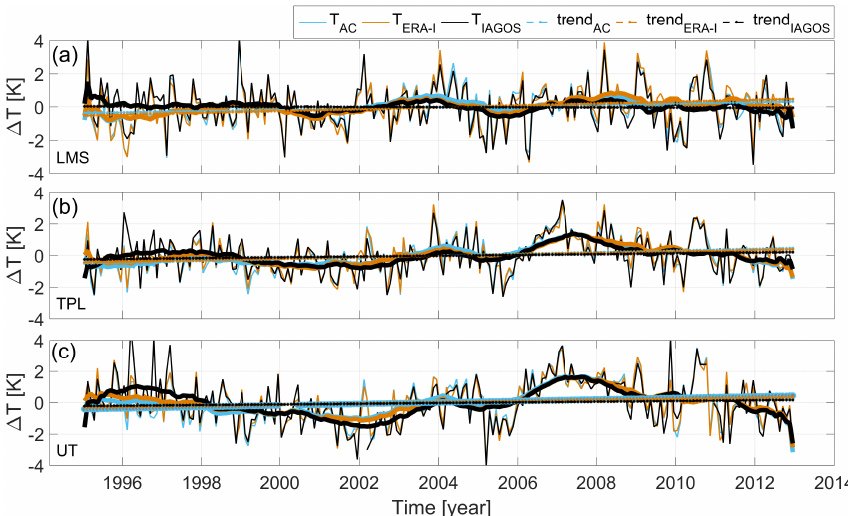
Figure 7. Anomalies in monthly averaged temperature in the (a) LMS, (b) TPL, and (c) UT over the North Atlantic region from IAGOS observations (black), ERA-I (orange), and aircraft measurements (AC, light blue). The aircraft measurements are assumed to be comparable to AMDAR data. The anomalies are smoothed with a 12-month running mean to highlight the behavior of the time series, which reflects the temperature trends by linear regression analyses (dashed